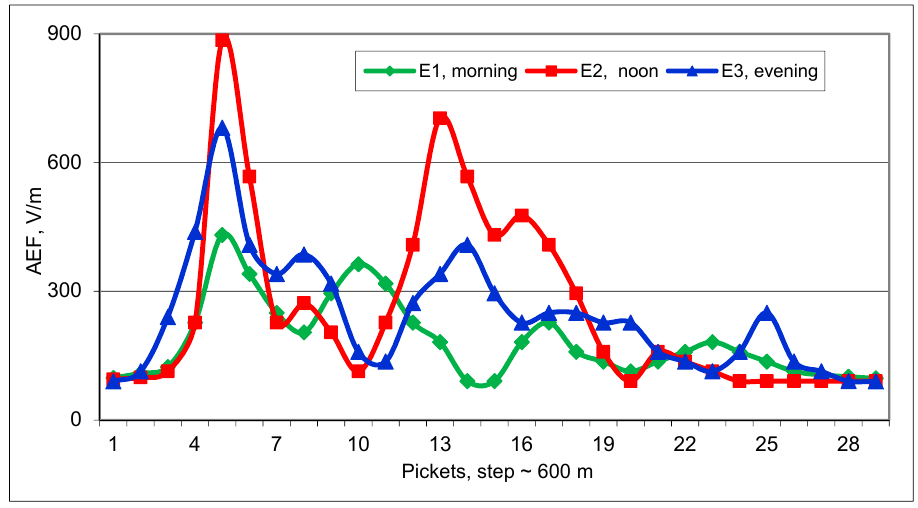
Figure 9. Spatial variations of the AEF on the Svetlogorsk-Uznozh highway over the urban water intake zone.